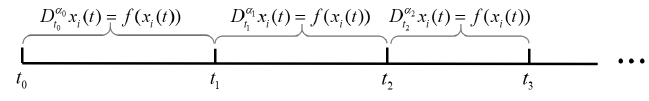
Figure 1. Variable-order fractional system with short